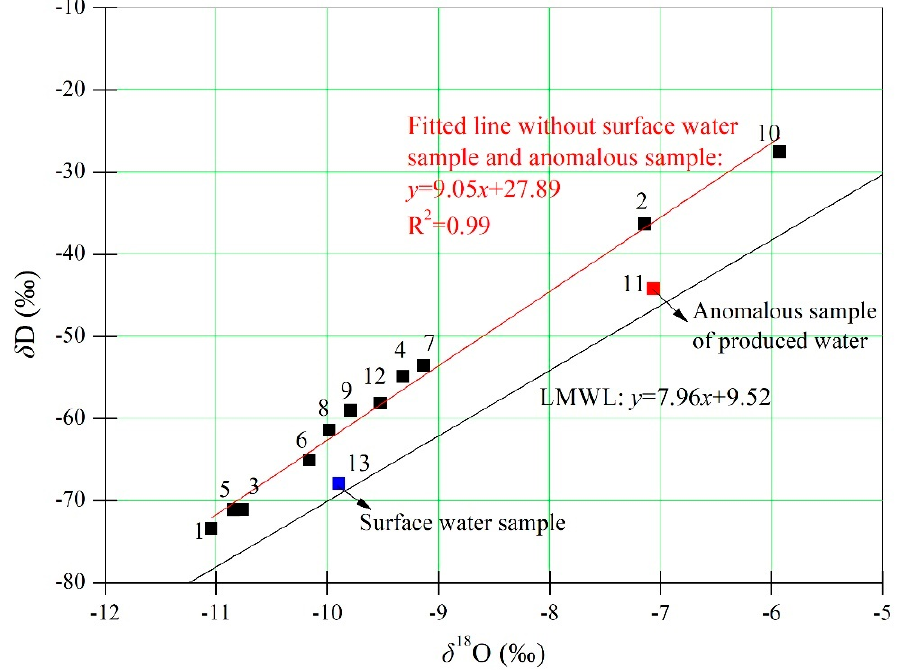
Figure 7. Linear fitting of δ D and δ 18 O in the produced water samples.